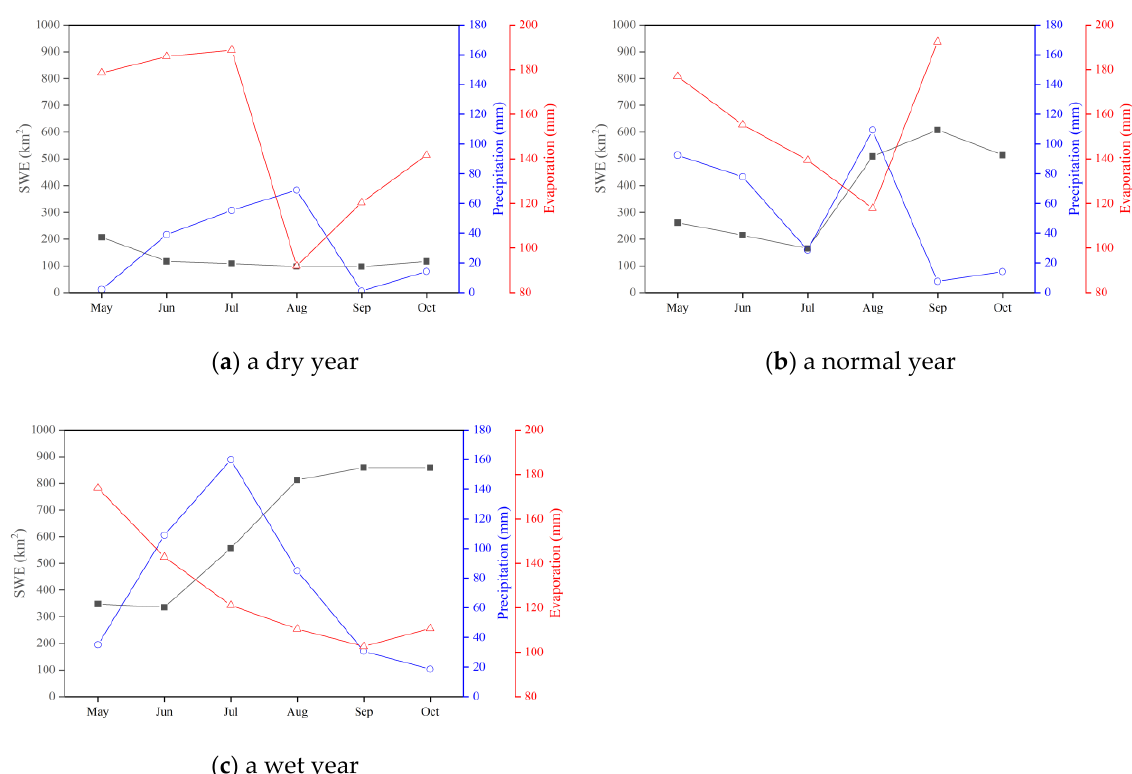
Figure 7. The relationship among surface water extent (SWE) of the top 10 largest connectomes, monthly mean precipitation, and monthly mean evaporation in the Momoge National Nature Reserve, China during ( a ) a dry year, ( b ) a normal year, and ( c ) a wet year. Data source: EC JRC/Google and China Meteorological Data Service Center.